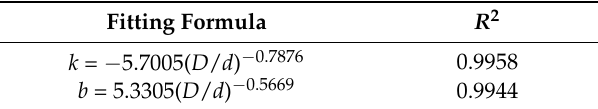
Table 6. Exponential fitting relations between parameters and D / d.